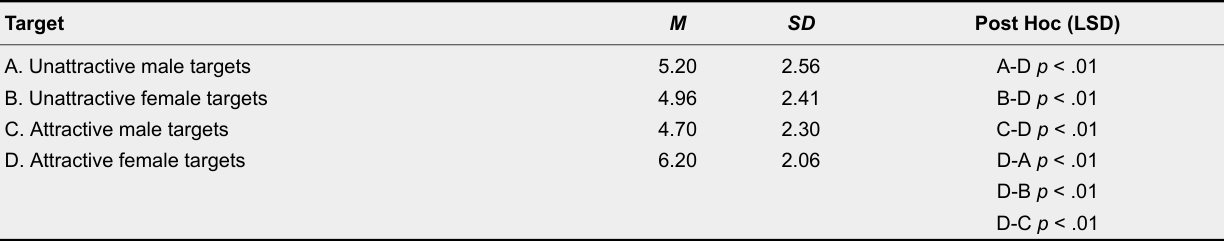
Perceived Conscientiousness: Simple-Effects Comparisons for the Interaction of Attractiveness and Target Gender.